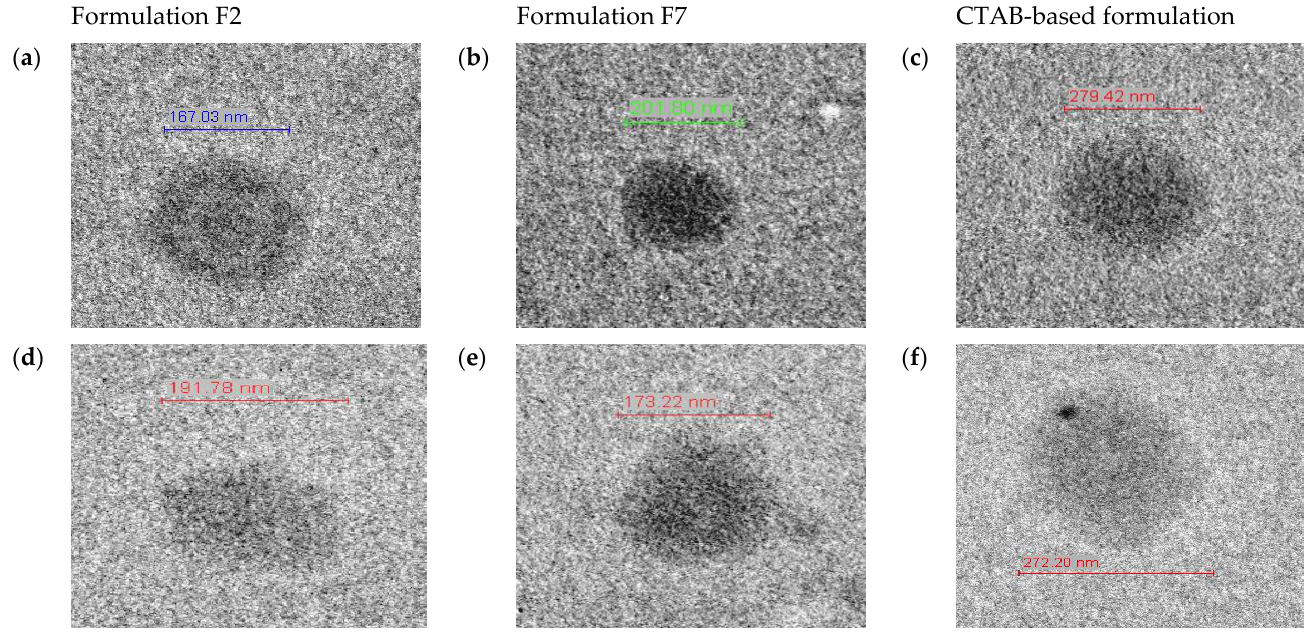
Figure 10. Images obtained using a transmission electron microscopy. F2 at day 0 ( a ) and at 28 days after production ( d ). F7 at day 0 ( b ) and at day 28 days after production ( e ). CTAB at day 0 ( c ) and at day 28 after production ( f ). The stability of the NEs was tested using an ocular formulation commonly commer- cialized as a cleaning solution for the eyes. One solution is a sterile saline solution, and